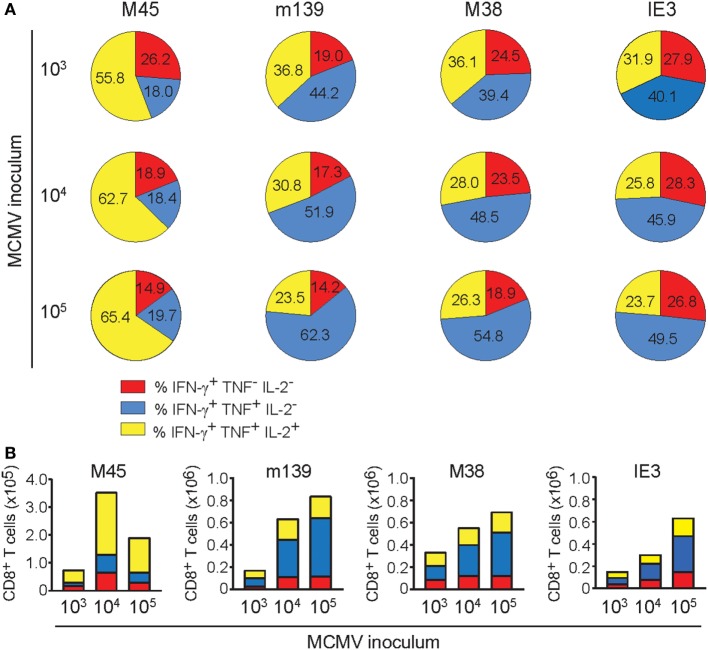
The dichotomy in cytokine polyfunctionality of inflationary versus non-inflationary CMV-specific T cells increases with the infectious dose. Following mouse CMV (MCMV) infection with different dosages (103, 104, or 105 PFU MCMV-Smith), the cytokine polyfunctionality of splenic CD8+ T cells was determined after peptide restimulation at day 400 post-infection. (A) Pie charts depict the percentages of the single (IFN-γ), double (IFN-γ/TNF), and triple (IFN-γ/TNF/IL-2) cytokine producers of each antigen-specific T cell population upon peptide stimulation. (B) Absolute counts of the single (IFN-γ), double (IFN-γ/TNF), and triple (IFN-γ/TNF/IL-2) cytokine producers of each antigen-specific T cell population upon peptide stimulation. Data represents mean values (n = 8 per group). Data were pooled from two independent experiments.